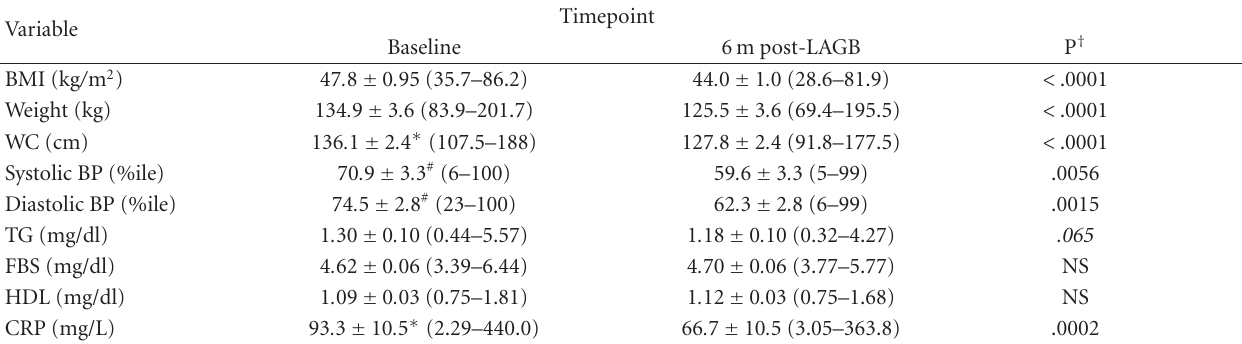
Table 2: Clinical characteristics and MeS variables at baseline and at 6 m post-LAGB ( N = 62).